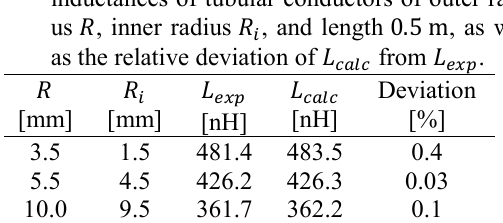
Table 2: Measured ( 𝐿 𝑒𝑥𝑝 ) and calculated ( 𝐿 𝑐𝑎𝑙𝑐 ) DC total inductances of tubular conductors of outer radi- us 𝑅 , inner radius 𝑅 𝑖 , and length 0.5 m , as well as the relative deviation of 𝐿 𝑐𝑎𝑙𝑐 from 𝐿 𝑒𝑥𝑝